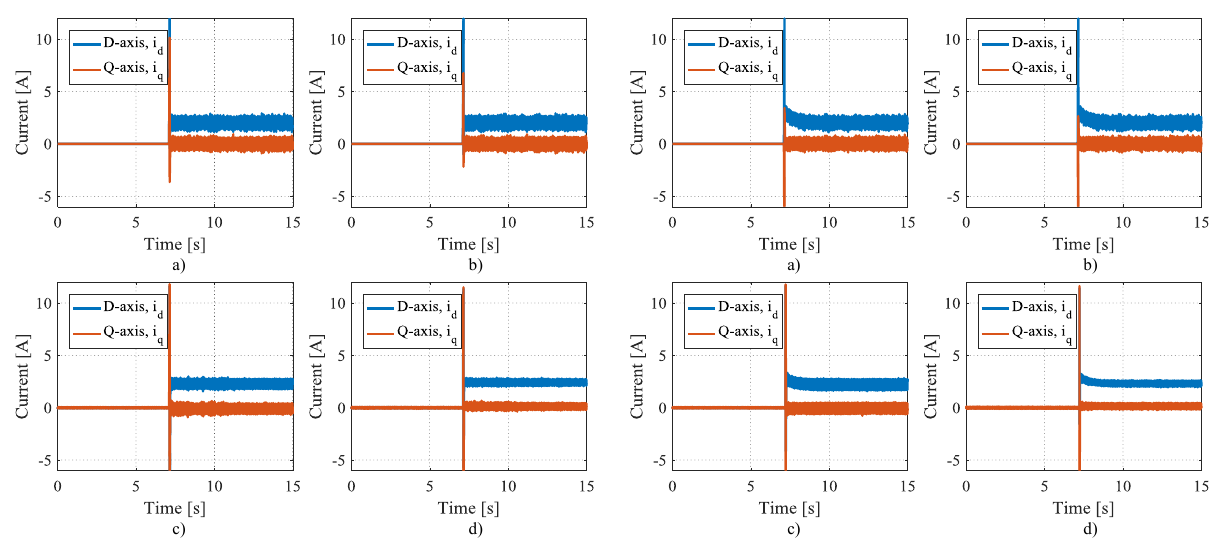
Figure 10: Simulated and measured DQ currents dur- ing the rotor lift-up with the pole placement controller. Simulation of the DQ axis cur- rent of the D-end and the ND-end motor are shown in a) and b), respectively. The measured DQ axis current of the D-end and the ND-end motor are shown in c) and d), respectively. Steady state RMS values for current in the simulation a) and b) are 2 A. For the measured steady state RMS current values c) 2.3 A and d) 2.4 A.